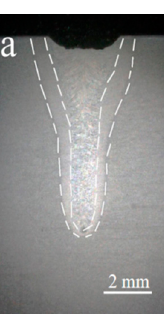
Figure 2. Optical microscopy of weld cross sections with different heat inputs of ( a ) 2.86, ( b ) 3.33, ( c ) 4.00, ( d ) 5.00 and ( e ) 6.67 kJ/cm.